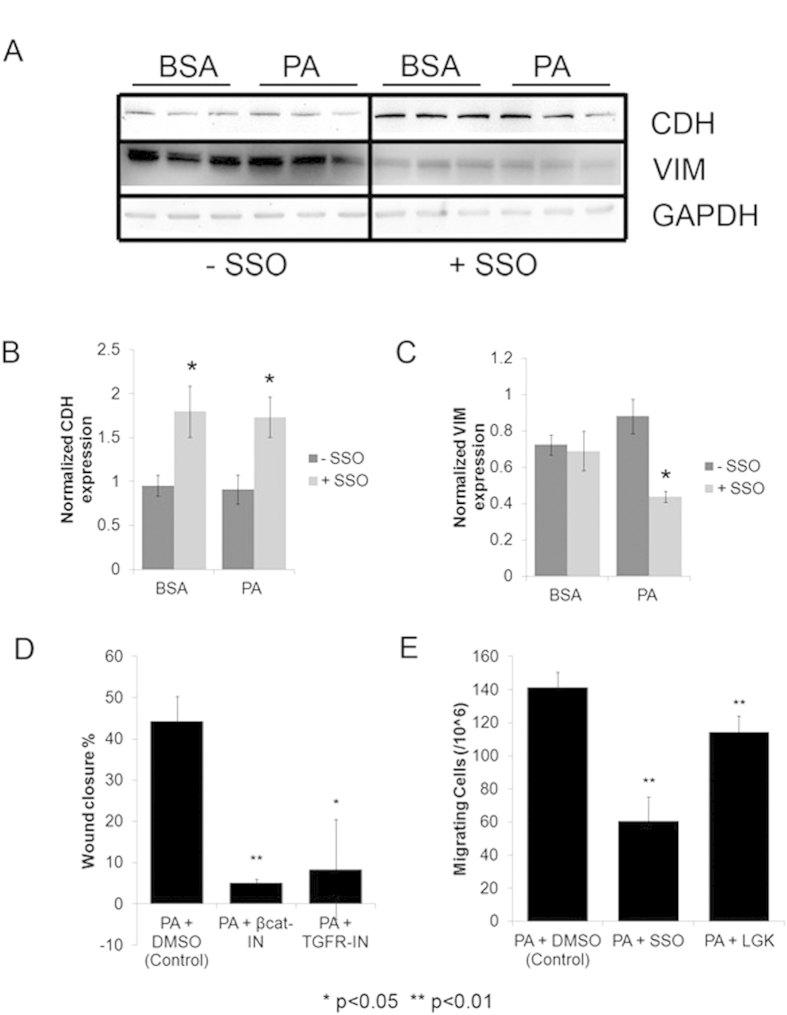
CD36 and TGF-beta/Wnt-signaling mediate PA effects.(A) Western blots showing expression of CDH and VIM in HepG2 cells treated with BSA or PA (0.3 mM) for 5 days with serum. Additionally, the cells were co-treated with either 100 μM SSO (CD36 inhibitor) or DMSO (solvent control). Equal amounts of sample (40 μg) were loaded in each well, run under identical conditions and blotted with specific primary antibodies against the indicated proteins. For clarity, blots have been cropped to show relevant bands (full length blots are presented in Supplementary Fig. 4). (B–C) Bar graphs showing quantification of blots indicating expression levels of CDH and VIM normalized to GAPDH in BSA or PA treated cells (n = 3). P-values indicate significance levels comparing SSO treated (+SSO) BSA or PA treated cells with DMSO control (-SSO) cells determined by Student’s t-test (two tailed). (D) HepG2 cells were treated with PA (0.3 mM) and DMSO (control), β-catenin/Tcf inhibitor III (100nM) or TGF-β1 RI kinase inhibitor (50 nM) in presence of serum for 5-days, followed by woundhealing assay in serum-free media over 48 hours. Bar graph indicates average wound closure (wound closure = 100 - % open wound area) normalized to 0 hour time point (n = 3). P-value indicates significance levels comparing the open wound area in inhibitor treated cells with control cells determined by Student’s t-test (two tailed). (E) HepG2 cells were treated with PA (0.3 mM) and DMSO (control), CD36 inhibitor SSO (100μM) or porcupine inhibitor LGK974 (100 nM) in presence of serum for 5-days, followed by Boyden’s chamber migration assay over 48  hours in serum-free media, with 10% FBS containing regular medium as chemoattractant. Bar graph indicates the average number of migrating cells (n = 3). P-value indicates significance levels comparing the number of migrating cells with inhibitor treatment against control, determined by Student’s t-test (two tailed).